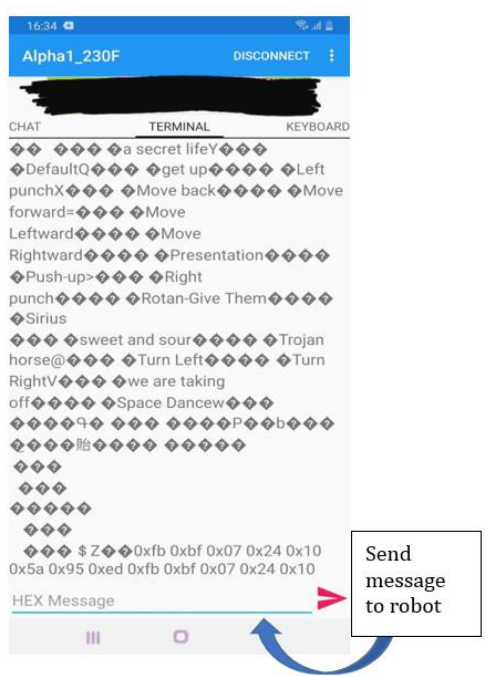
Figure 16. Message sending to robot through SPP android application.